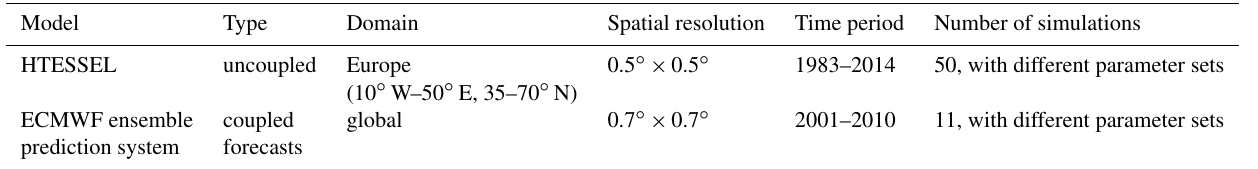
Table 1. Overview of performed model experiments.